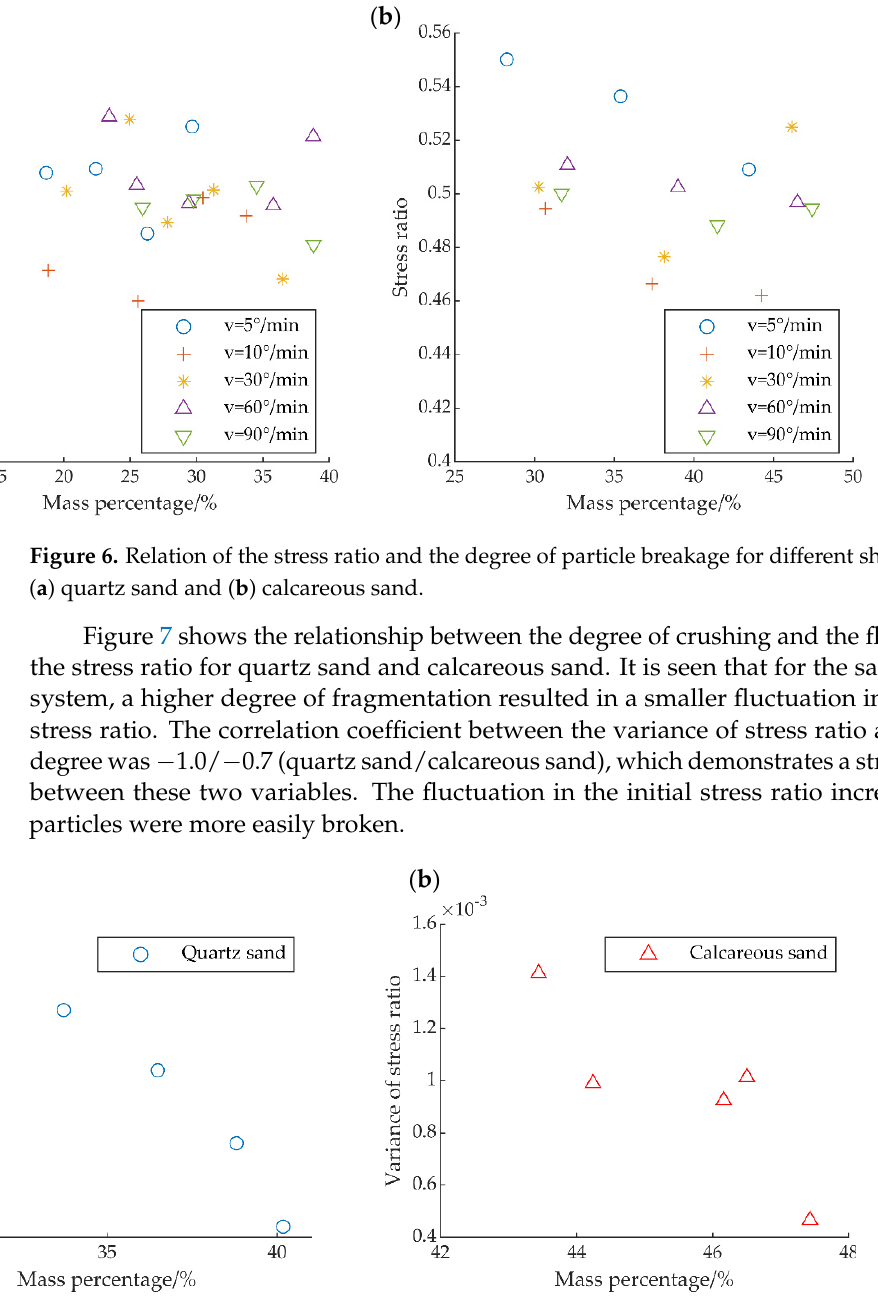
Figure 7. Relation of the variance of the stress ratio and the degree of particle breakage for different particle systems: ( a ) quartz sand and ( b ) calcareous sand.